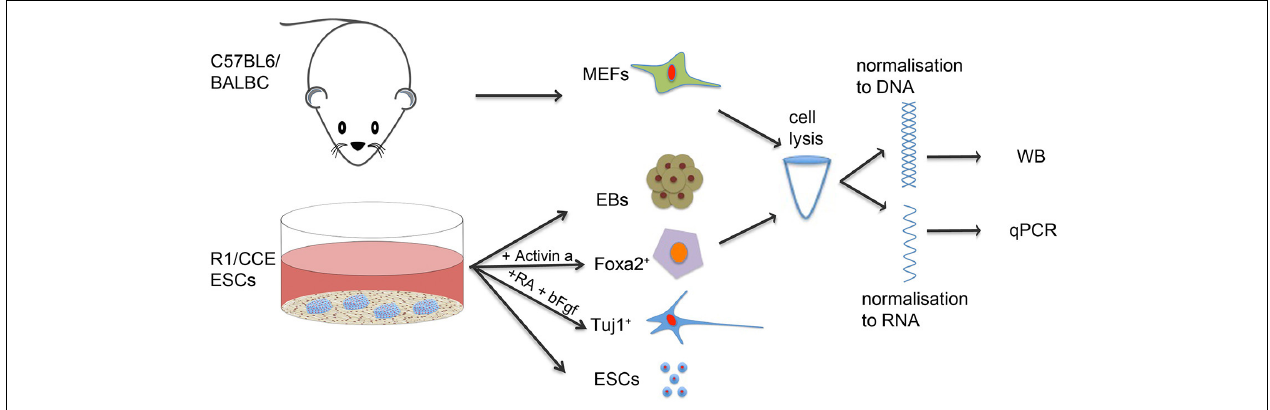
FIGURE 1 | Experimental outline. R1 and CCE ES cells (ESCs) were cultured under ESC culture conditions or differentiated either spontaneously to Embryoid Bodies (EBs) or specifically to differentiated cells expressing neuronal (TUJ1) and endodermal (FOXA2) markers. Mouse Embryonic